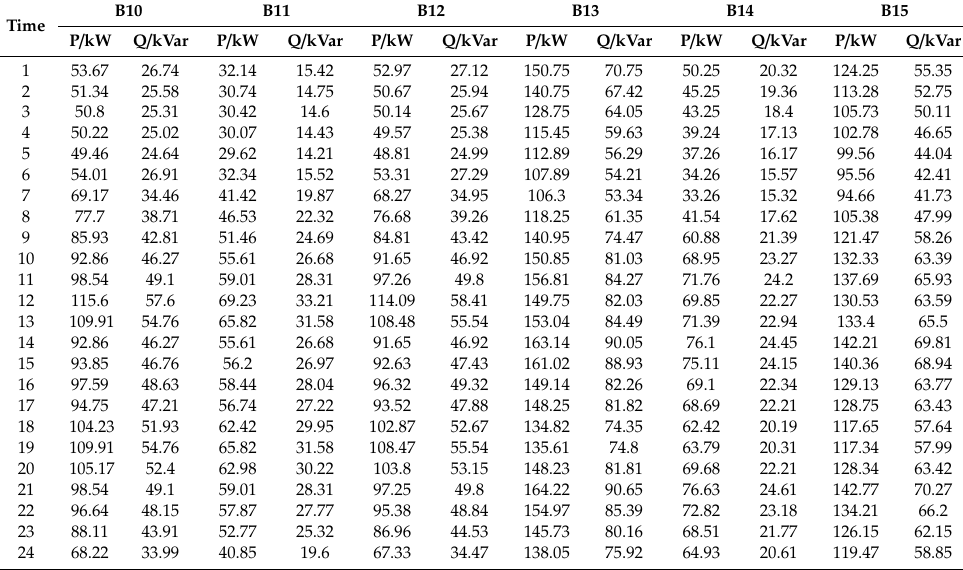
Table A2. The bus load at di ff erent time of nodes